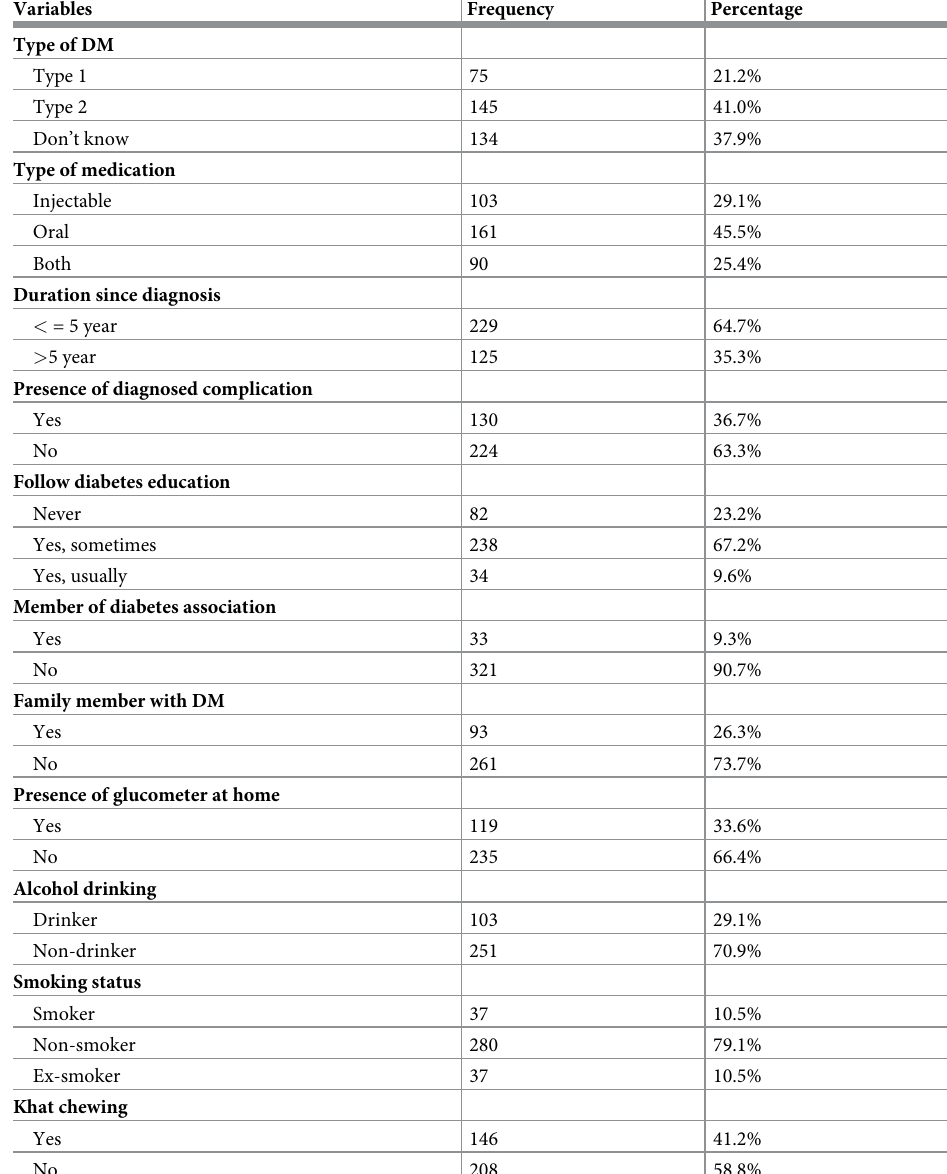
Table 2. Clinical and relevant characteristics of diabetic patients in JUMC,